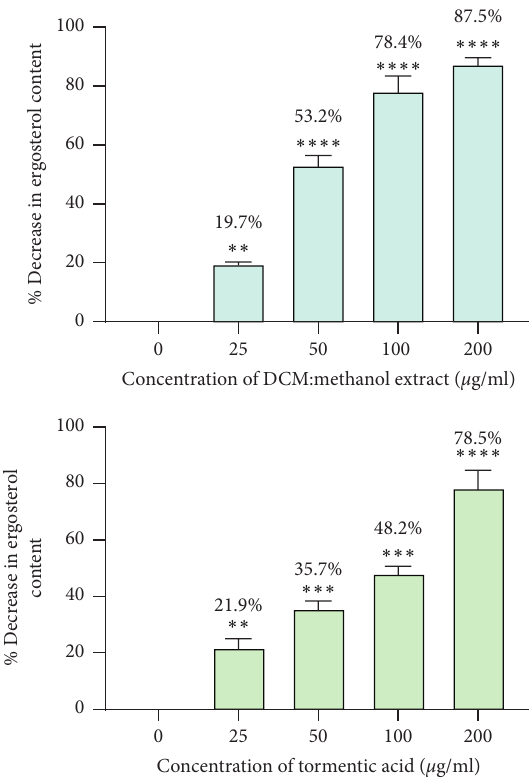
Figure 10: Percentage decrease in ergosterol with increasing concentration of DCM: methanol extract and tormentic acid. The data represent the mean of two experiments, and the standard deviation was shown by the error bars. ∗∗∗∗ p < 0 . 00001 and ∗∗ p < 0 .